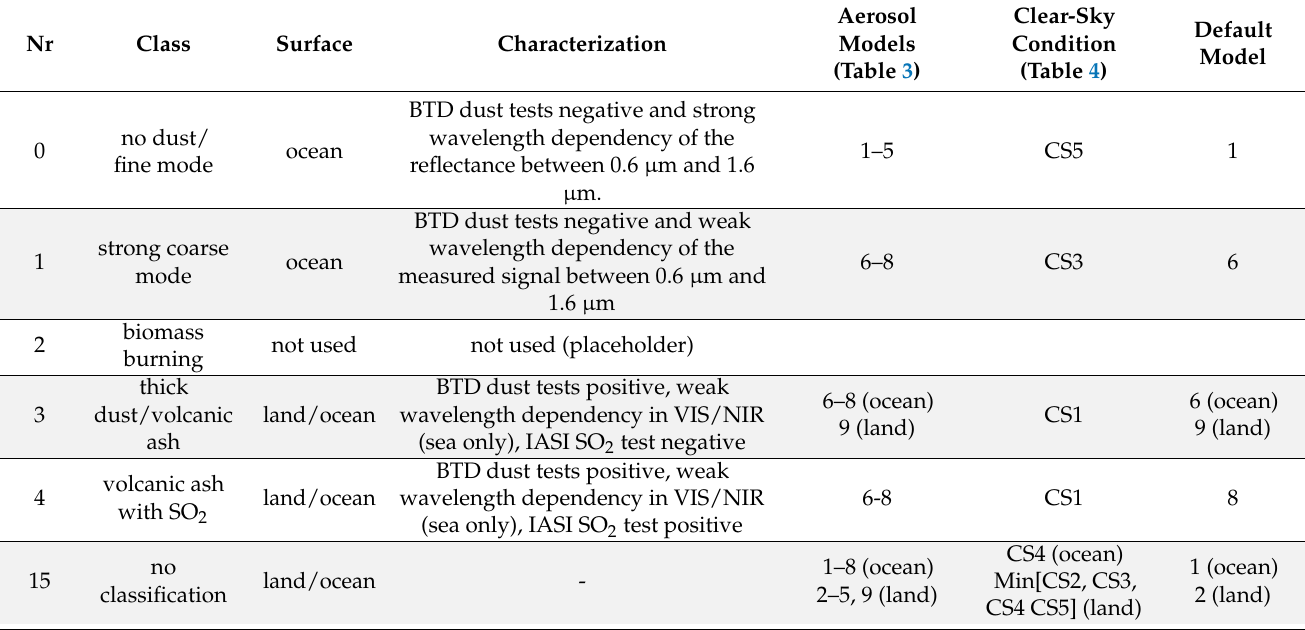
Table 5. Aerosol classifications used within PMAp, the associated clear-sky conditions, and the default aerosol model considered for the AOD